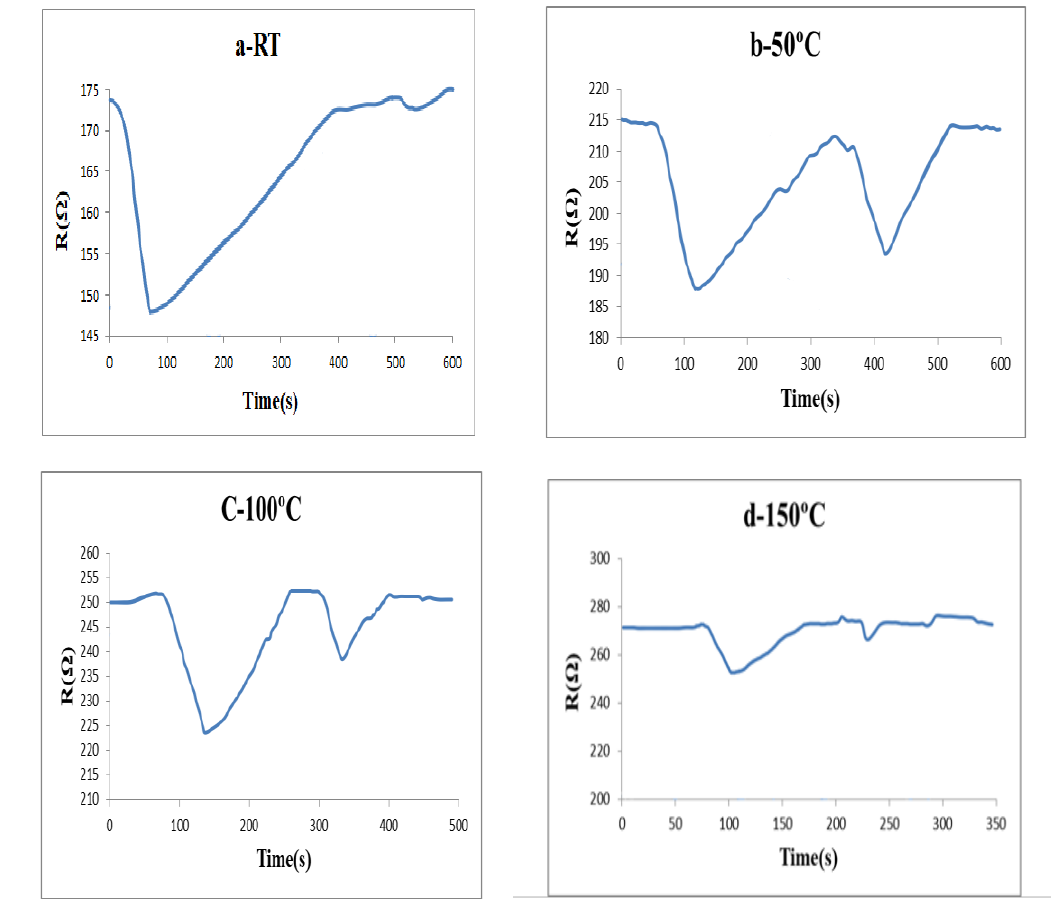
Fig.6: Resistance-Time curves of FSWCNTs/CoO NPs sensor at RT, 50 °C, 100 °C, 150 °C when exposed to NO gas. 2